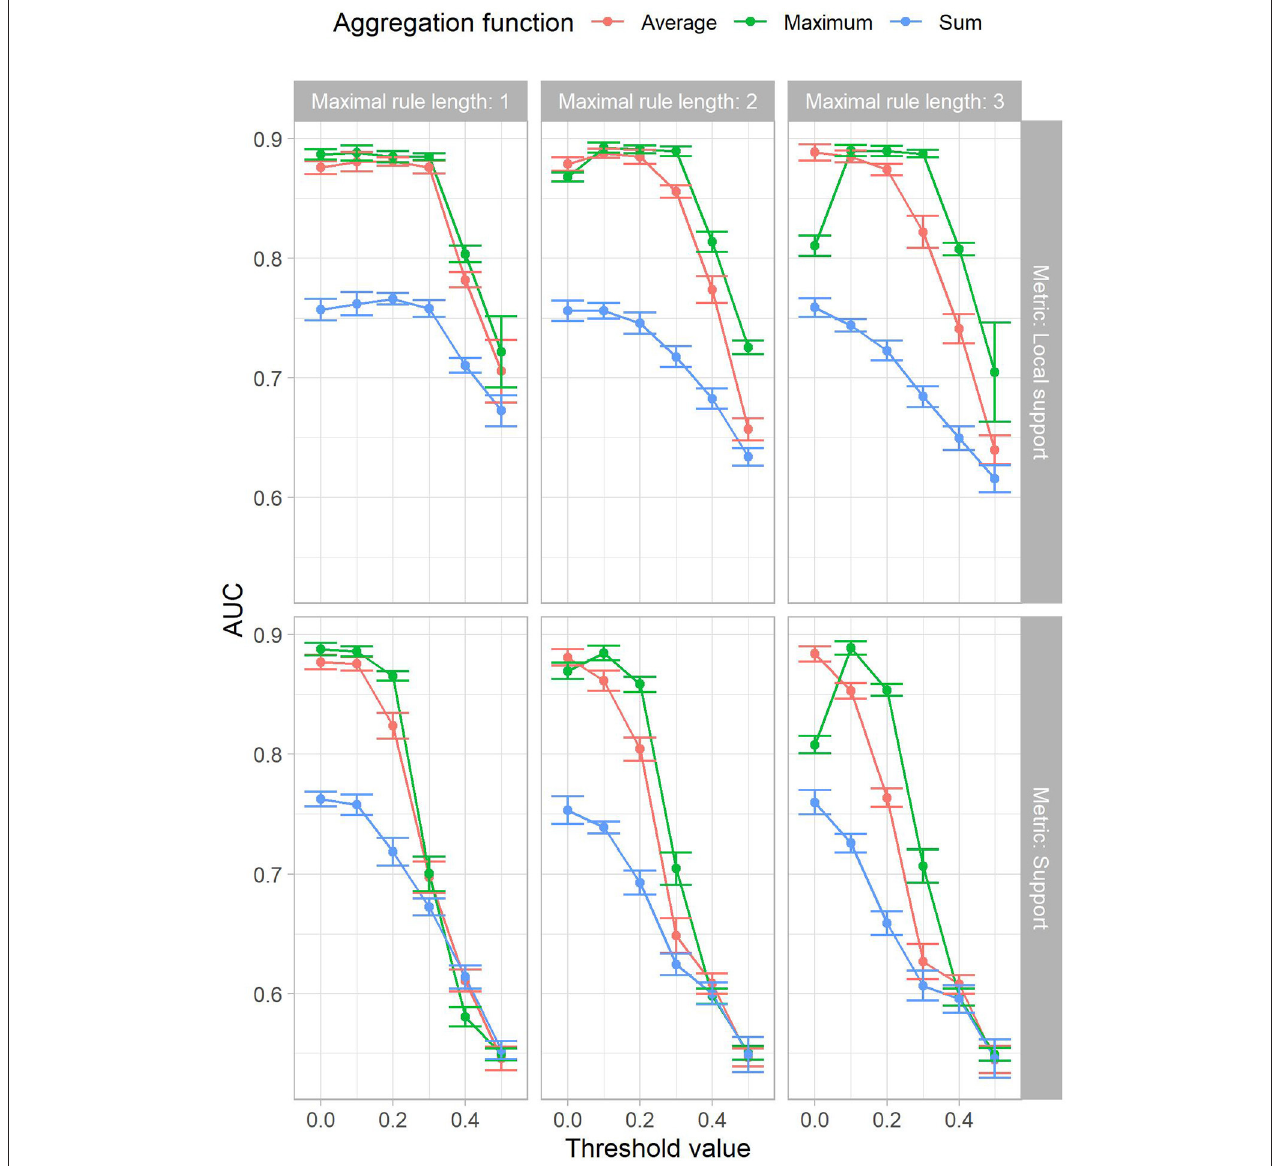
FIGURE 1 | The mean AUC achieved in the experiments by maximal rule length (horizontal facets), local support or support (x-axis in the top resp. bottom facets) and aggregation function (color). The standard deviation is shown by the size of the error